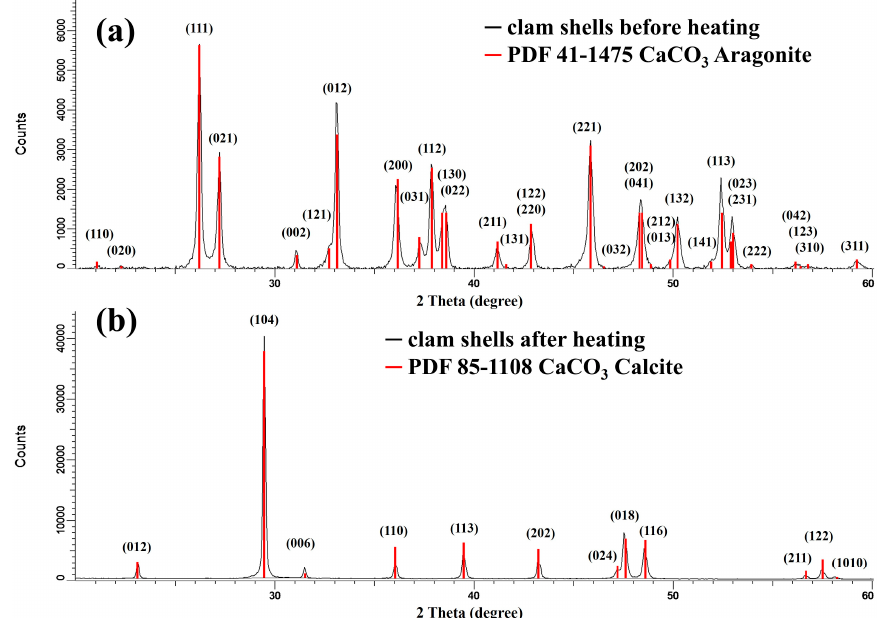
Figure 1. Powder X-ray diffraction (XRD) patterns of clam shells before heating ( a ); and clam shells after heating at 500 °C for 2 h ( b ).